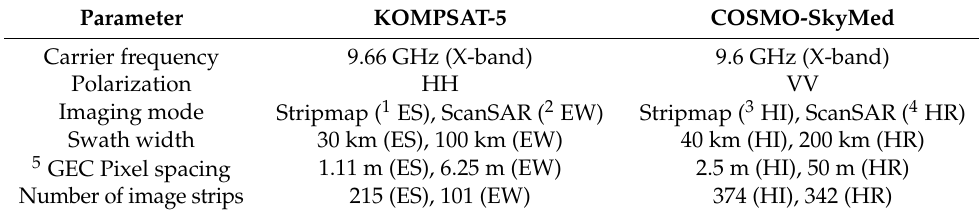
Figure 1. Image acquisitions of KOMPSAT-5 (red) and COSMO-SkyMed (green) along the trajectory of the MOSAiC ice floe (black) from 4 October 2019 to 16 May 2020. Table 1. Image and sensor parameters of the SAR satellites used.